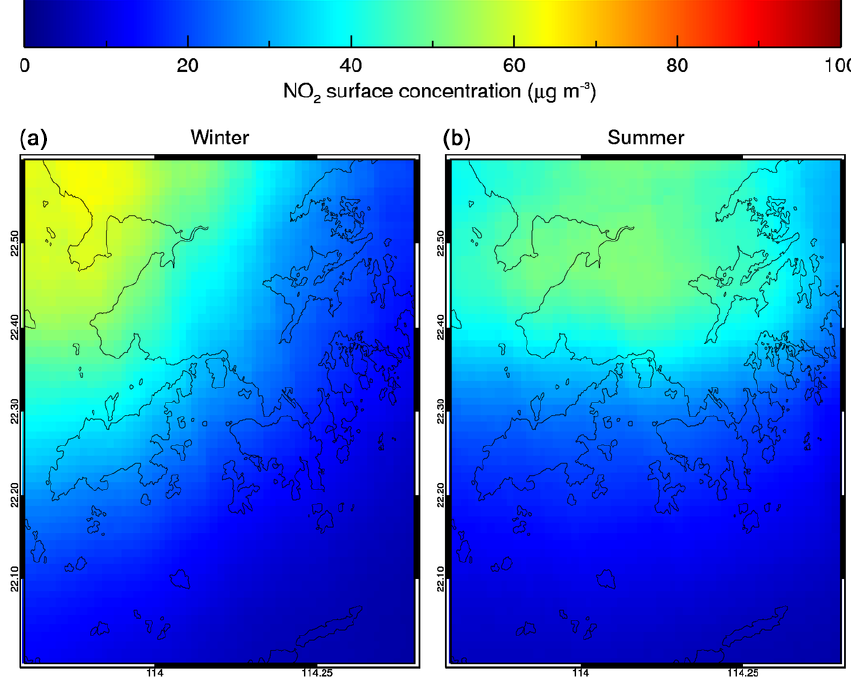
Figure 7. The mean surface NO 2 concentration inferred from OMI tropospheric VCDs using MACC-II reanalysis data, between 2005 and 2012. Data is plotted for winter (left, November-April) and summer (right,